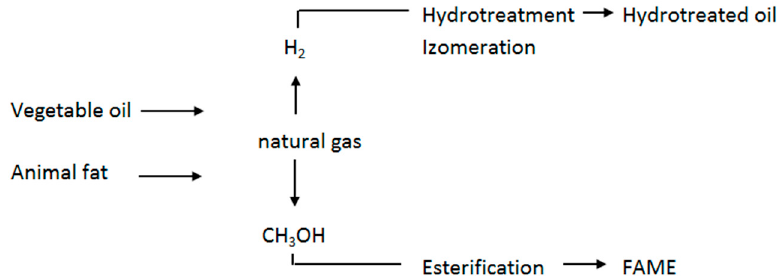
Figure 1. Simplified diagram for the production of hydrotreated oils and fatty acid methyl esters. FAME: fatty acid methyl esters.